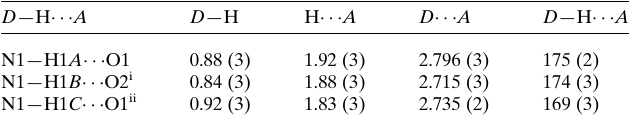
Table 4 Hydrogen-bond geometry (A˚ , (cid:5) ) for